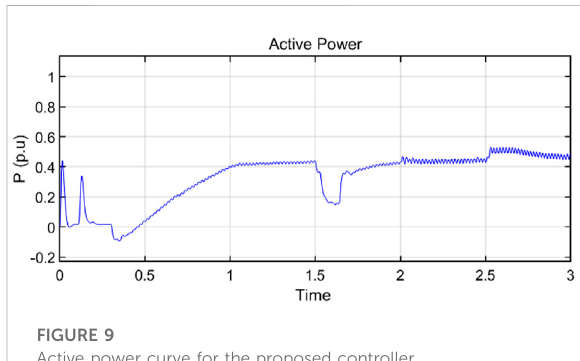
FIGURE 9 Active power curve for the proposed